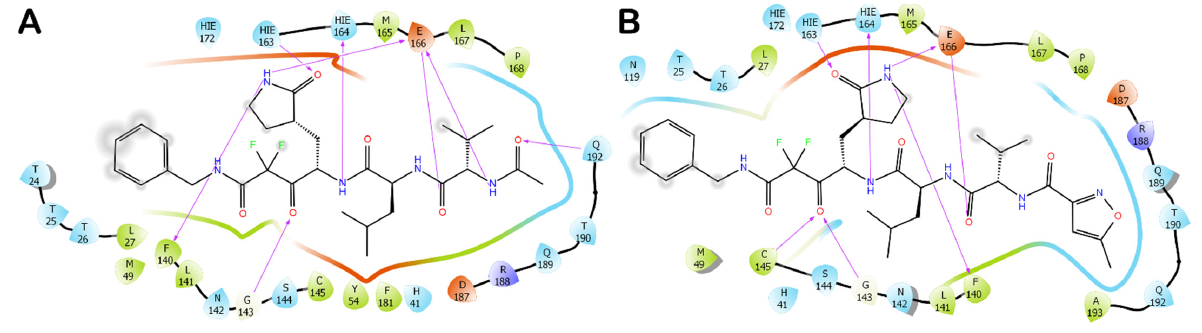
Figure 4. Detailed binding modes of compound 4 (panel A ) and compound 5 (panel B ). Pictures were generated by ligand interaction diagram available in Maestro (Maestro, Schrödinger LLC, release